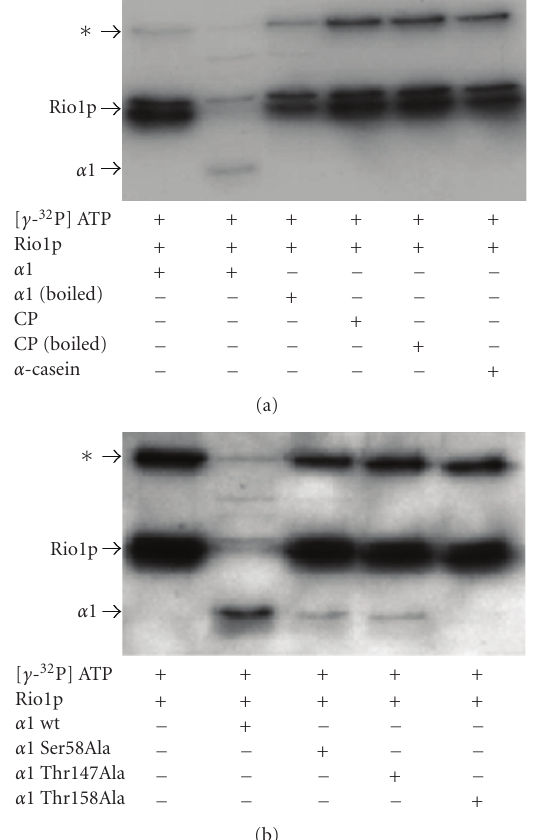
Figure 4: Rio1p phosphorylates α 1 at Ser and Thr residues. (a) Phosphotransfer of Rio1p to α 1 is catalyzed using α 1-His 6 from recombinant E. coli as a substrate. Phosphotransfer was assayed using the protein substrates indicated as follows: α 1-His 6 (boiled and unboiled) from recombinant E. coli , 20S CPs of α 1-His 6 and β -StrepII subunits (boiled and unboiled) from H. volcanii and α - casein from bovine milk (boiled), as indicated. (b) Phosphotransfer of Rio1p to α 1 is reduced by site-directed α 1 protein variants Ser58Ala, Thr147Ala and Thr158Ala. The α 1 wild type and protein variants were purified from recombinant E. coli and were not boiled prior to assay. Phosphotransfer was detected by autoradiography using Rio1p-StrepII purified by StrepTactin chromatography and γ - 32 P P-ATP as a